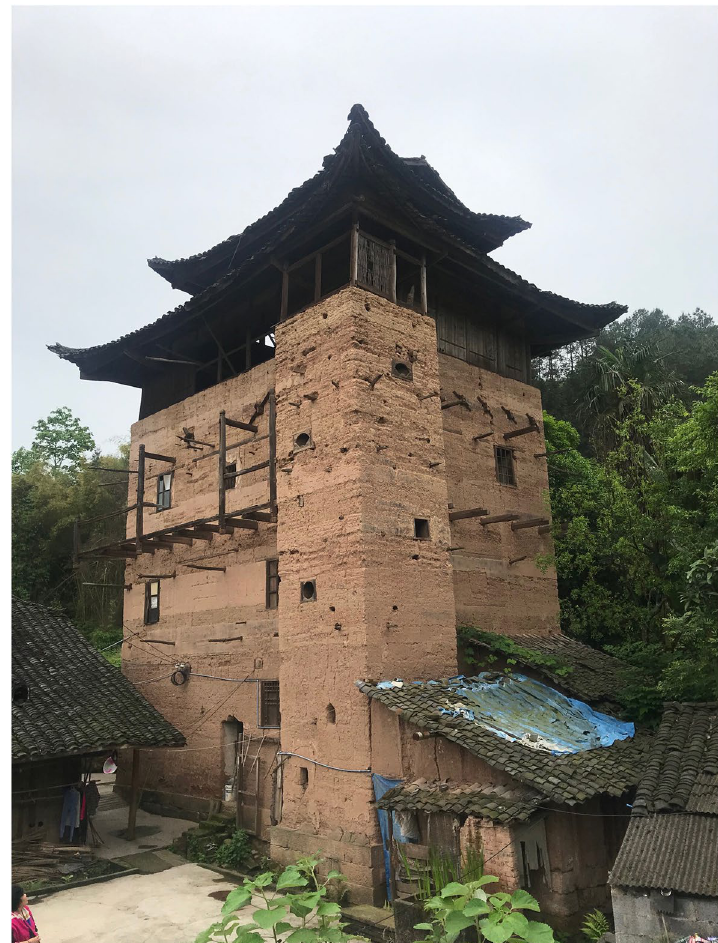
Fig. 6 Wang’s ancestral temple watchtower including traditional techniques in Shixi, Nanchuan (Source: the author)